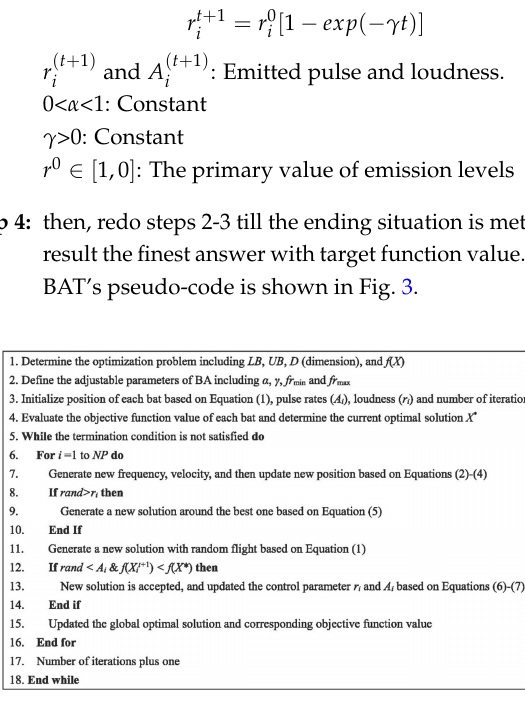
Fig. 3. Pseudo-code of the standard BAT